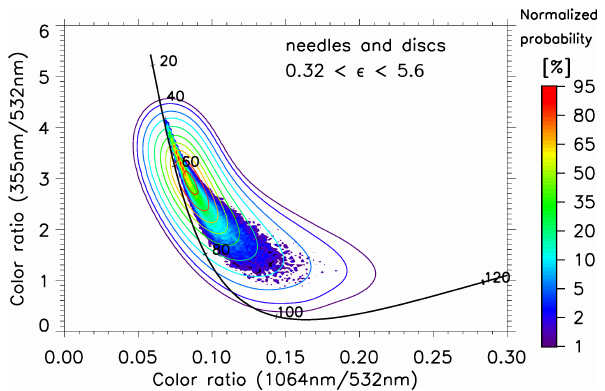
Figure 5. Filled contours: measured multi-year statistic of color ra- tio distribution observed by ALOMAR RMR lidar for strong NLCs ( β > 13 × 10 − 10 m − 1 sr − 1 ). Contour lines: modeled CR distribu- tion for spherical particle simulation from 67 to 72 ◦ N with simu- lated measurement error. χ 2 refers to the difference between model and measurements; see Fig. 6. All distributions are normalized to 100% for their respective probability density